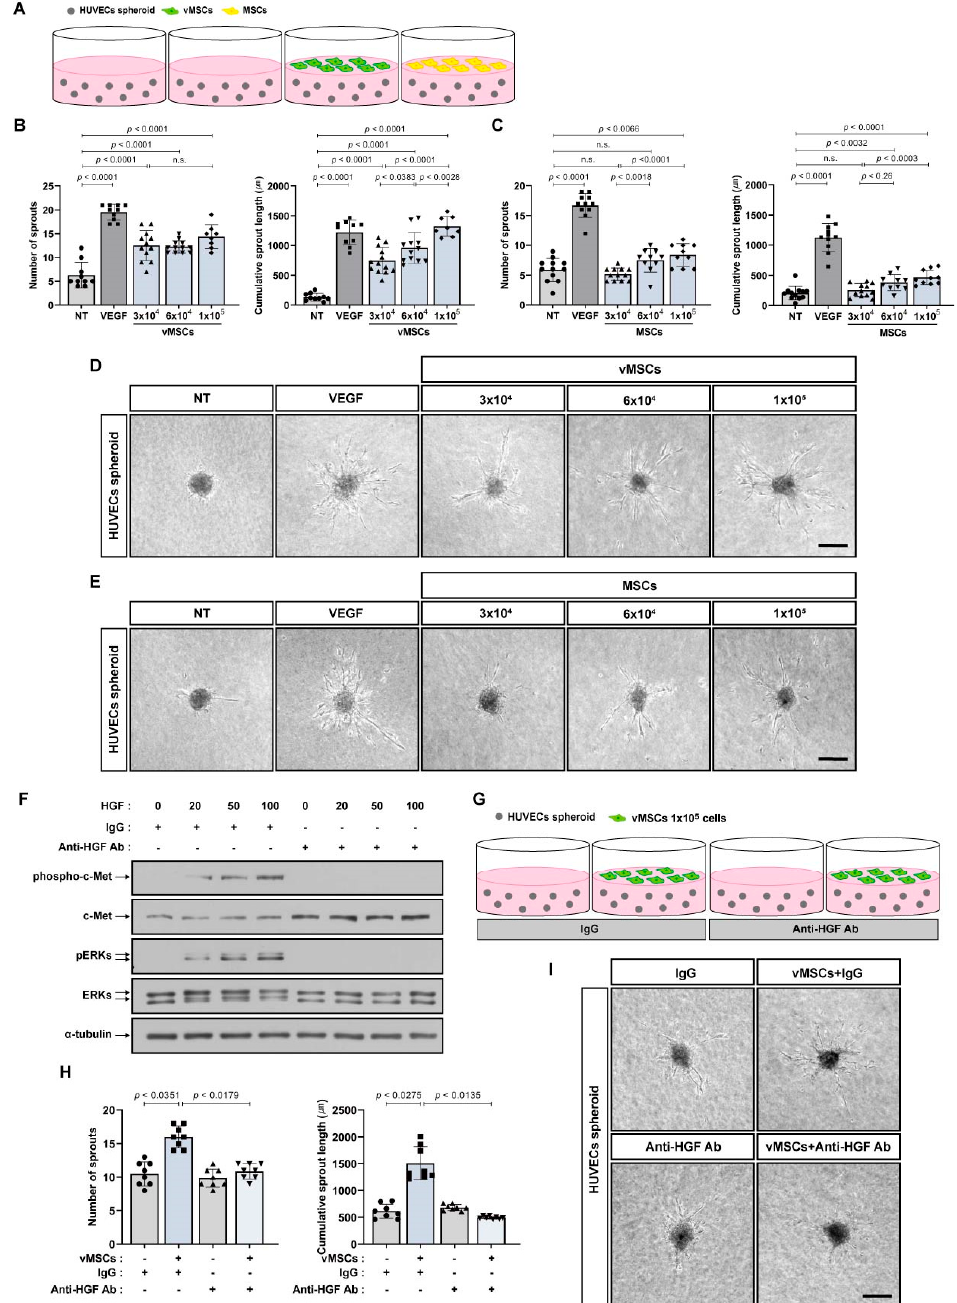
Figure 4. In vitro angiogenic sprouting of HUVEC spheroids in response to vMSCs-derived